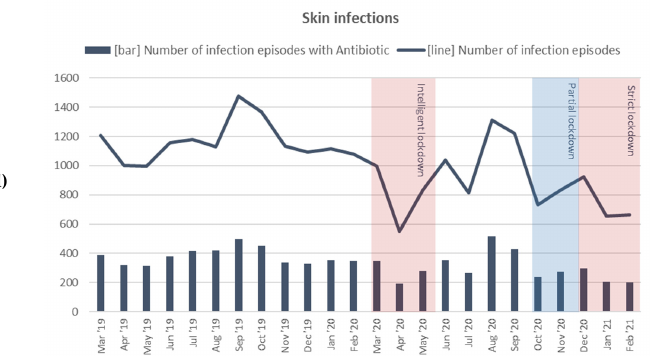
Figure 1. Number of episodes and episodes with antibiotic prescription for ( a ) respiratory tract/ear ( b ) urinary tract ( c ) gastrointestinal, and ( d ) skin infections over time per month, from March 2019 to February 2021.